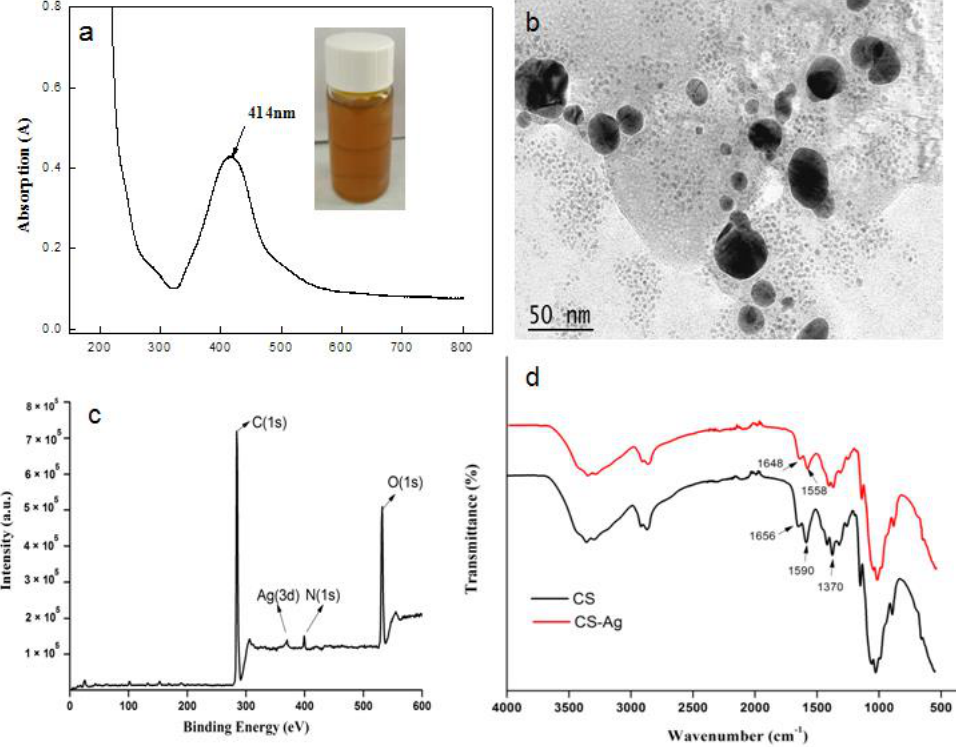
Figure 1. Characterization of DCNC-AgNPs and CS- DCNC-AgNPs: ( a ) UV-Vis absorption spectra of DCNC-AgNPs. The figure in the inset shows the color of synthesized DCNC-AgNPs. ( b ) TEM image of DCNC-AgNPs. ( c ) XPS spectra of CS-DCNC-AgNPs. ( d ) FTIR spectra of CS-